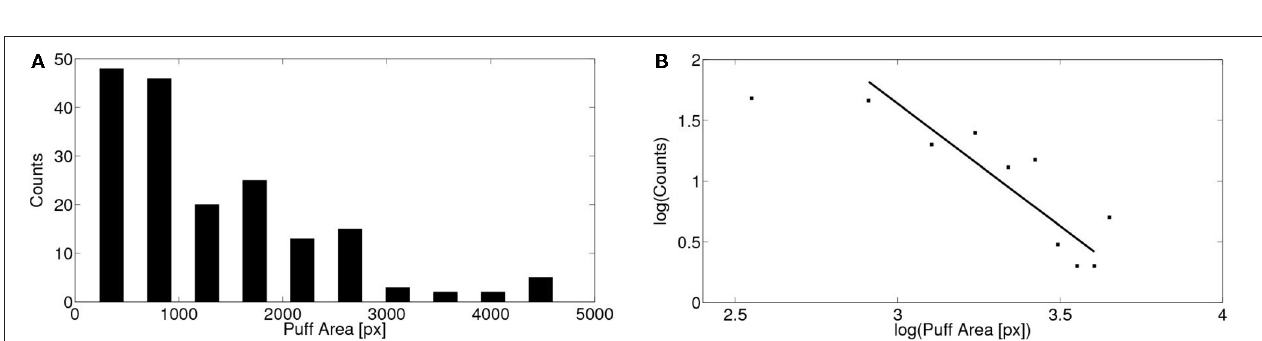
FIGURE 6 | Distribution of puff areas obtained experimentally. (A) Similar to Figure 5 but for the area covered by the puffs. Areas were determined as explained in the “Materials and Methods” section pooling data from 179 puffs observed in 12 cells. (B) Same as (A) but on a logarithmic scale.